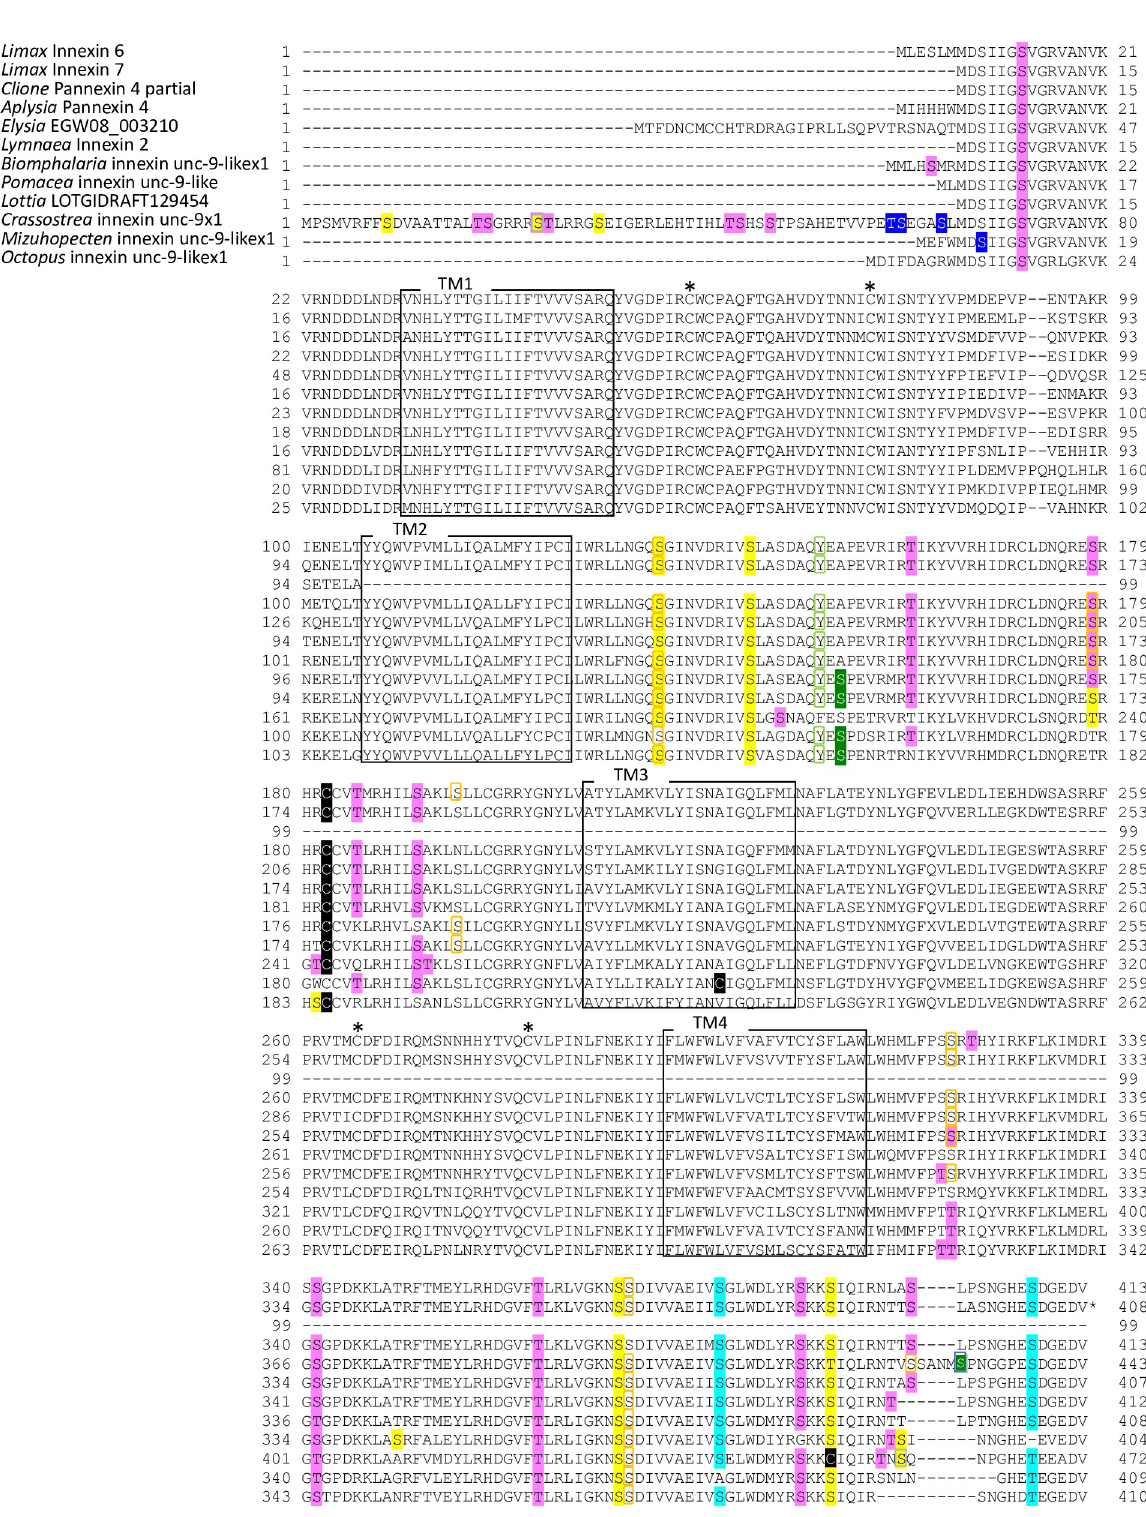
Fig 6. Protein sequence alignment of molluscan innexin orthologs in Group 4. Alignment of deduced amino acid sequences of Limax innexin 6 and 7 with orthologous innexin sequences. The boxes show the four transmembrane domains, while the asterisks indicate the extracellular cysteine residues. The potential S-nitrosylation sites are shaded in black. The phosphorylation sites are indicated with shading or box in magenta (protein kinase C), yellow (protein kinase A), blue (casein kinase 1), cyan (casein kinase 2), orange (P34cdc2), green (p38-mitogen-activated protein kinase), light green (proto-oncogene tyrosine-protein kinase Src), and gray (protein kinase G).